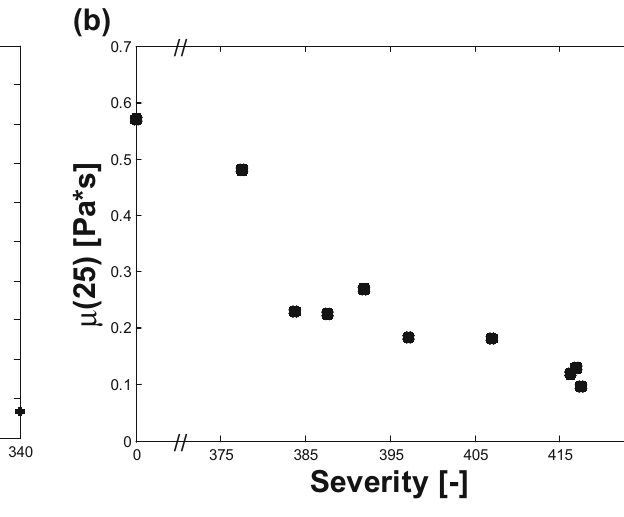
Fig. 2 Viscosity as function of ( a ) process temperature ( b ) severity